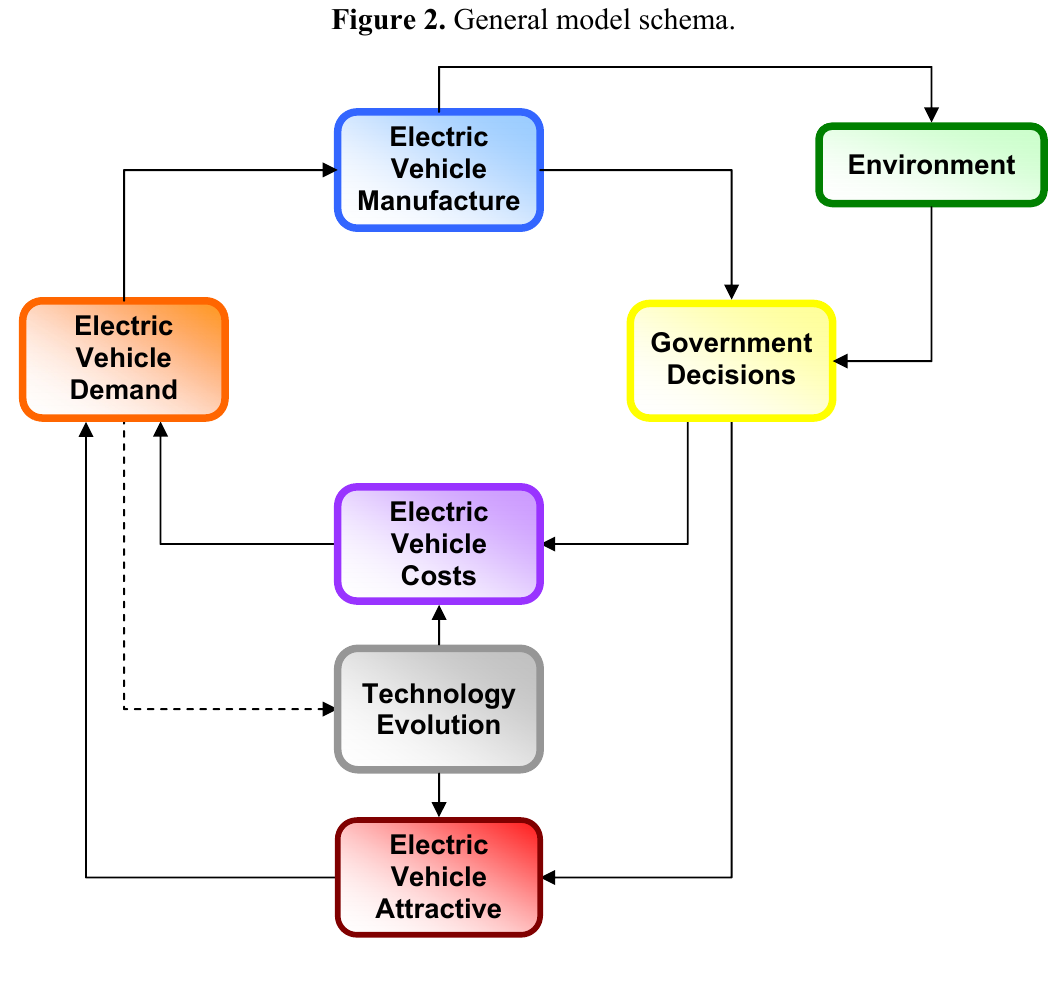
Figure 2. General model